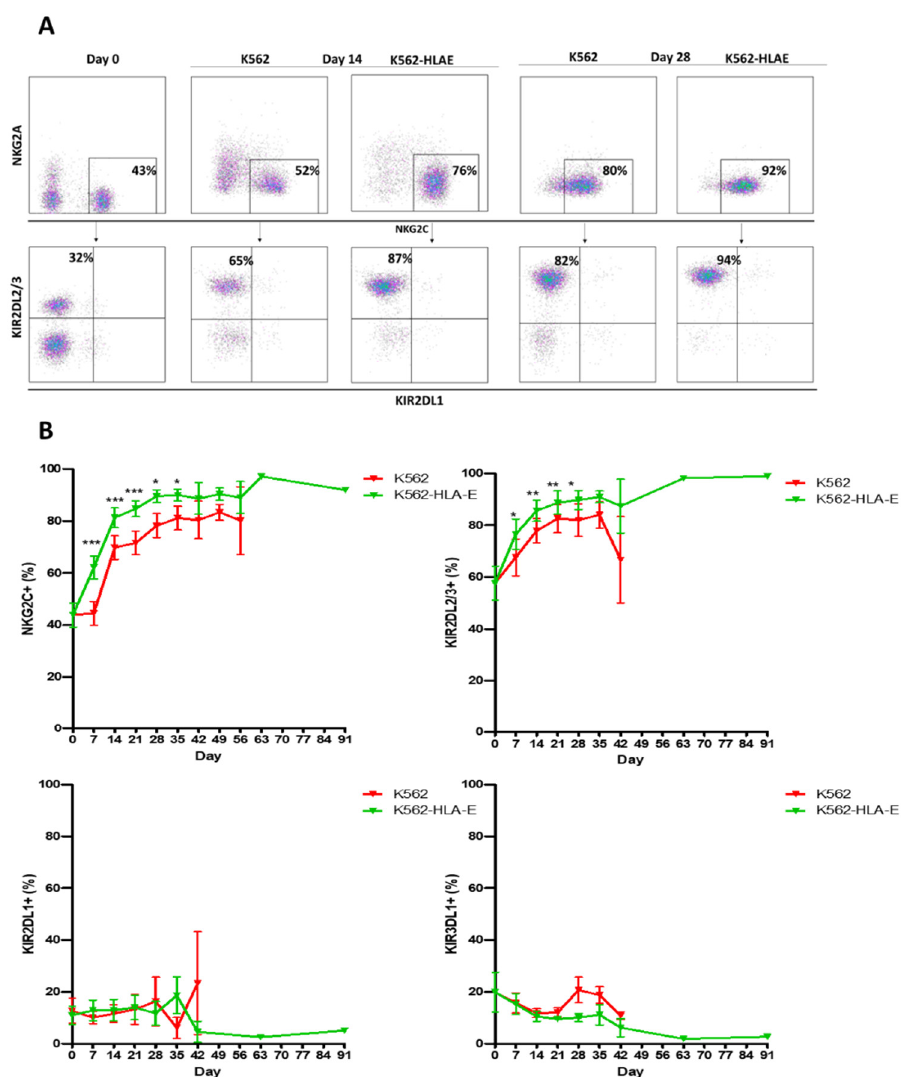
cultured with K562-HLA-E cells rather than with K562 cells (Figure 3A). Long-term survival (over 3 months) was observed in the adaptive NKG2C+ cells with single KIR2DL2/3+ expression generated with K562-HLA-E cells rather than in conventional NK cells generated with K562 cells (Figure 3B). Enhanced NKG2C+ population and self-specific KIR were also observed in cells obtained from C1C2 and C2C2 donors (Supplementary Figure S1).